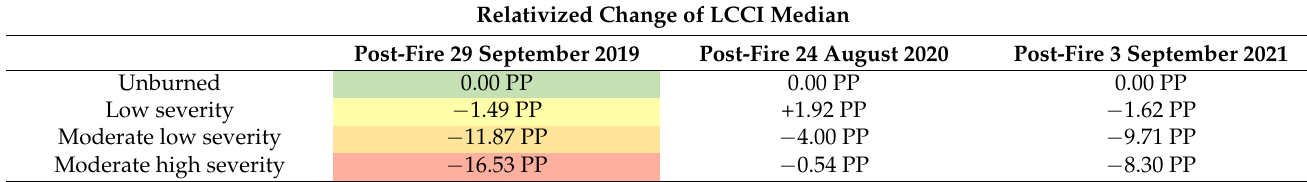
Table 9. LCCI time series: relativizing the phenological difference of the selected vegetation index dates at the El Saco basin.